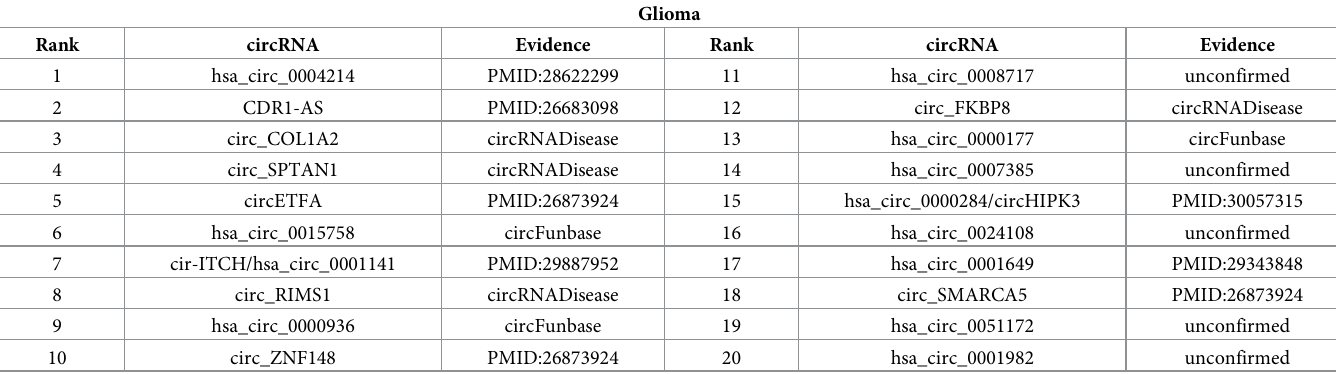
Table 6. The top 20 glioma related candidate circRNAs.